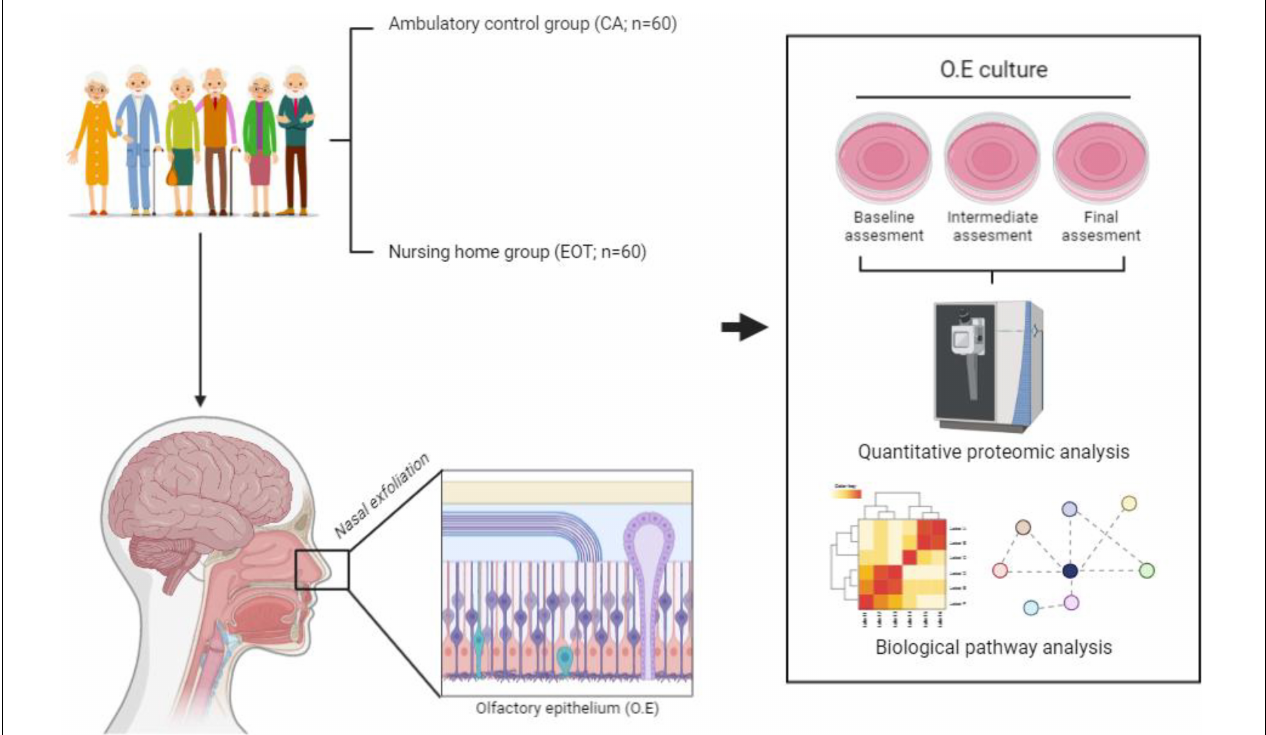
FIGURE 1 | Olfactory proteomics workflow to be implemented in parallel with the